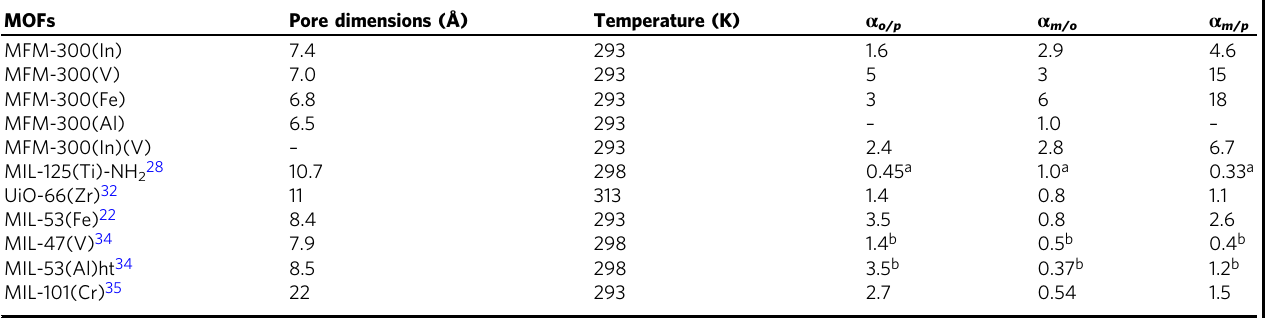
Table 1 Comparison of the chromatographic separation factors ( α ) for xylene isomers in different MOFs. MOFs